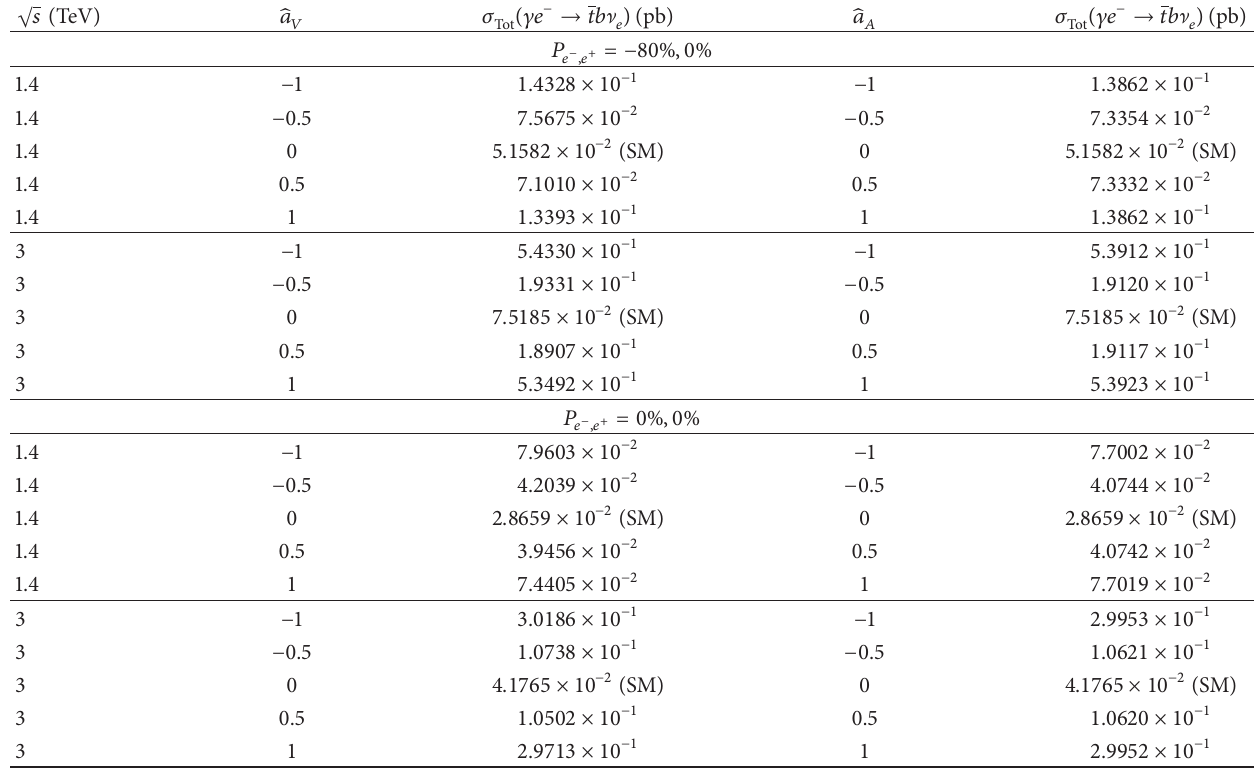
Table 3: Total cross sections for the process 𝛾𝑒 − → 𝑡𝑏 ] 𝑒 ( 𝛾 is the Compton backscattering photon) as a function of ̂𝑎 𝑉 and ̂𝑎 𝐴 for 𝑏